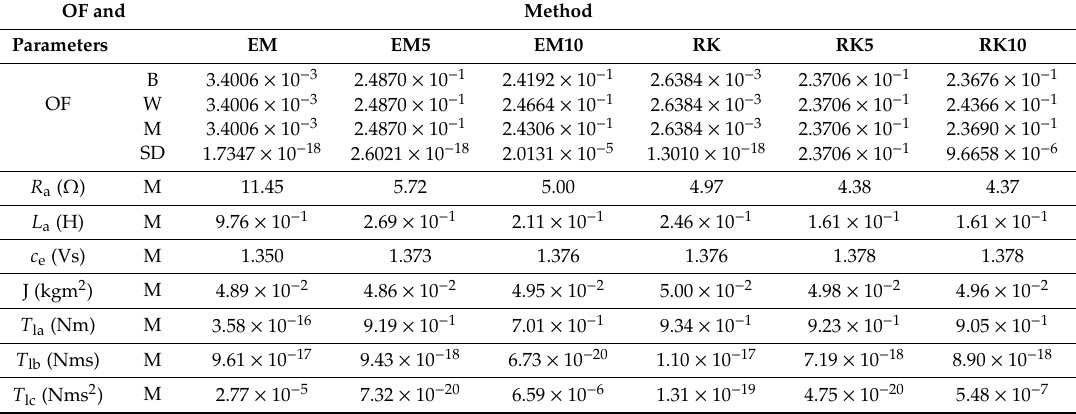
Table 25. OF and Mean value of the calculated parameters for 50 independent runs using EM, EM5, EM10, RK, RK5, and RK10 for MD2.